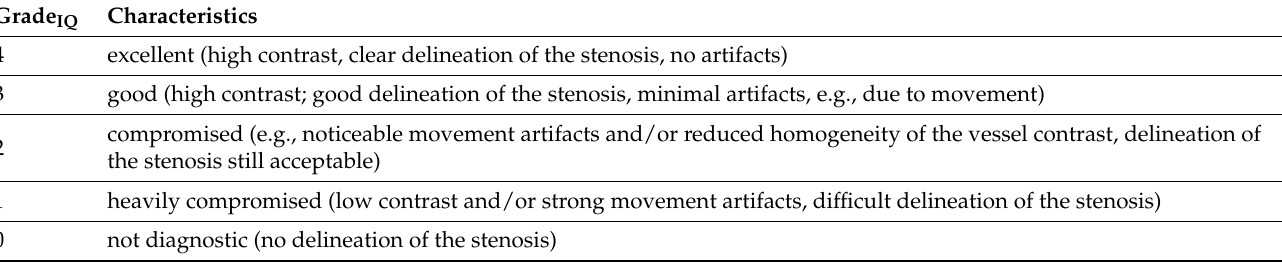
Table 1. Image Quality